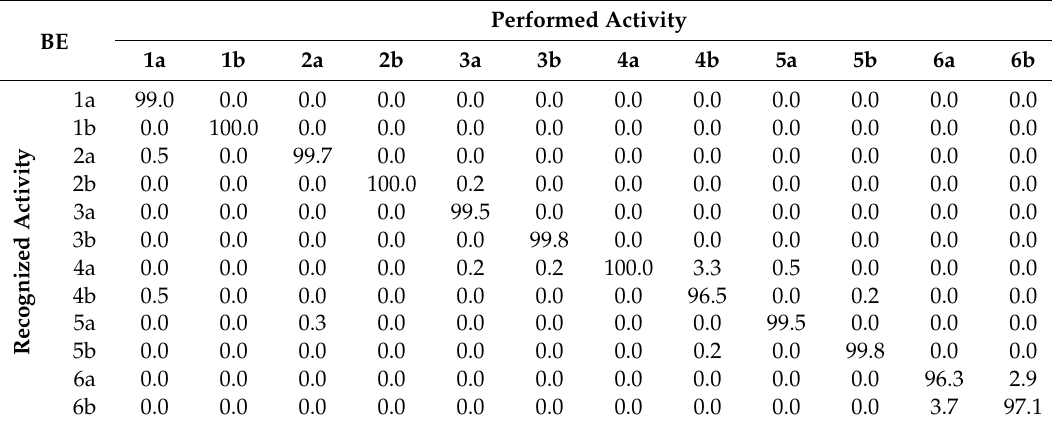
Table A3. Matrix of recognition errors (in %) of 12 motor activities 1a ÷ 6b in test set for all volunteers together for sensor